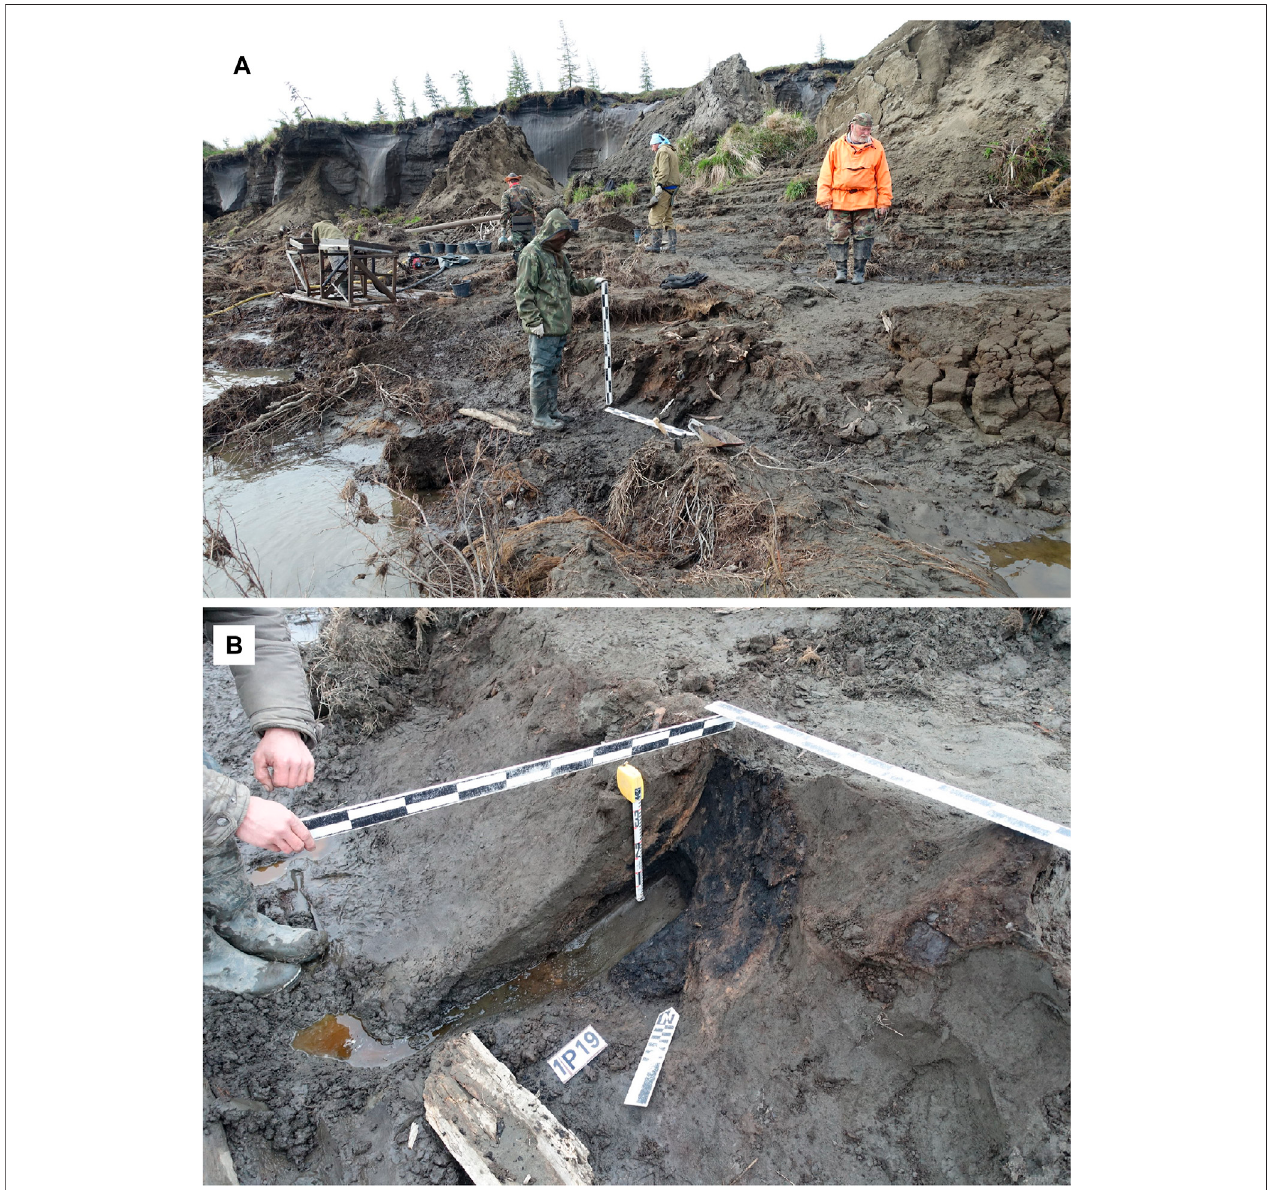
FIGURE 14 | Yana site complex, excavations at the Northern Point area. Excavations of frozen deposits from a collapsed block containing a portion of the cultural layer (A) and a hearth structure discovered in this block remnant (B) . Photo: Elena Pavlova.